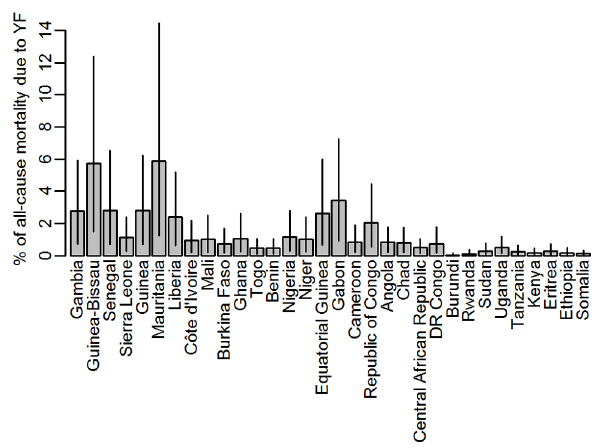
Figure 5. Percentage of the all-cause mortality attributable to yellow fever by country. Grey bars indicate the point estimates, black lines the range spanned by the 95% CIs of the burden estimates. Countries are ordered west to east.